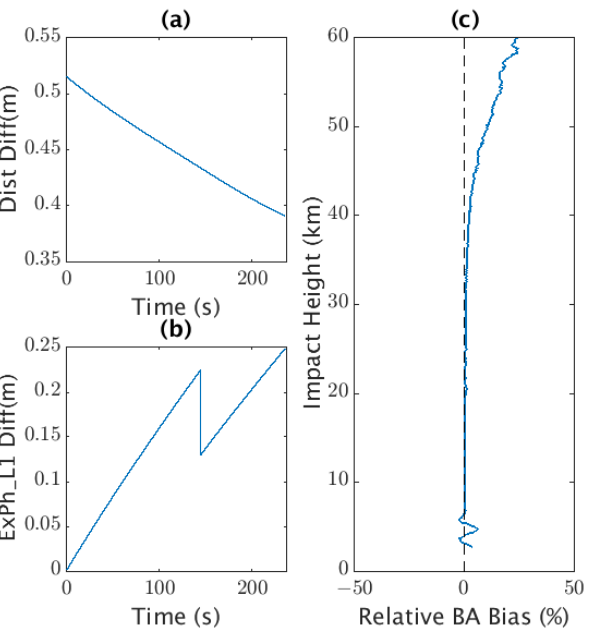
Figure 10. Using different POD solutions can yield different bending angle profiles. The POD difference ( a ) is up to 50 cm and changes with time for the case: 2 October 2019, 18:46 UTC for G15 of C2E1. The jump in the excess phase ( b ) is due to the cycle slip removal difference. The relative bending angle bias ( c ) can be about 10% around 50 km.